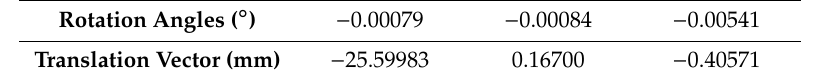
Table 2. External parameters of the RGB camera and depth camera.